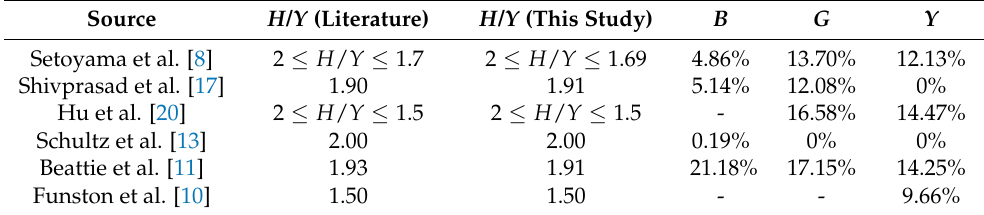
Table 1. Room-temperature comparison of various moduli with experimental literature. Absolute % error provided in the table. Zero represents that data was within error bars when compared to literature. For Setoyama et al. [8] and Hu et al. [20], average error provided. Source H / Y (Literature) H / Y (This